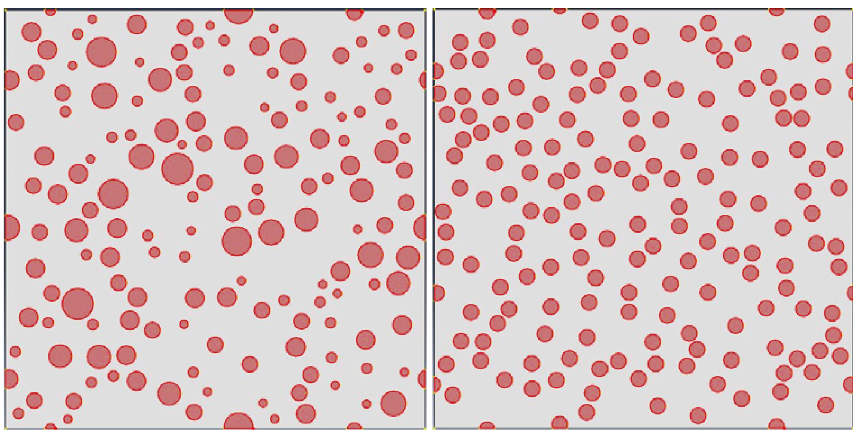
Figure 6: Two kinds of RVE random adsorption sequence models. Table 3: Results for particle size and diameter in RVE ( V